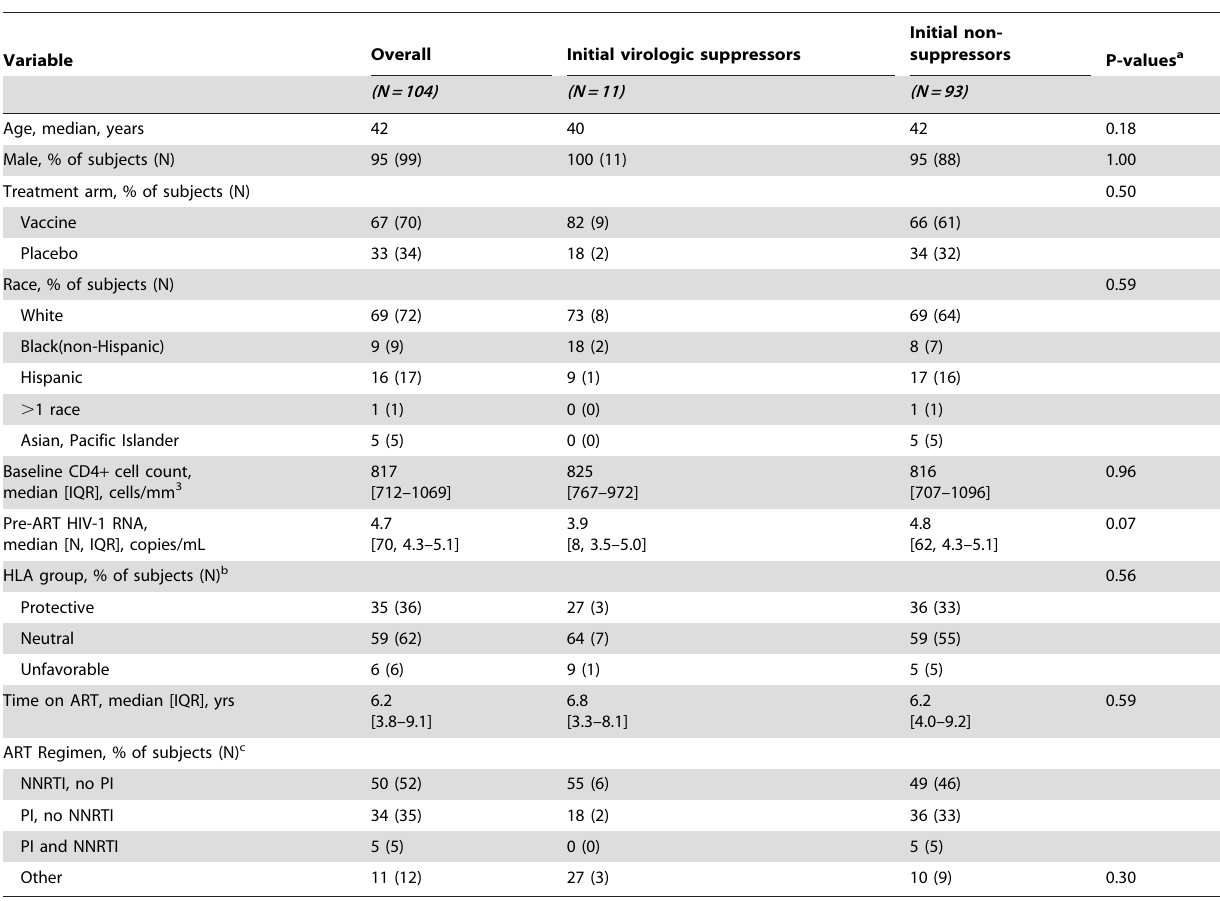
Table 1. Baseline characteristics of the